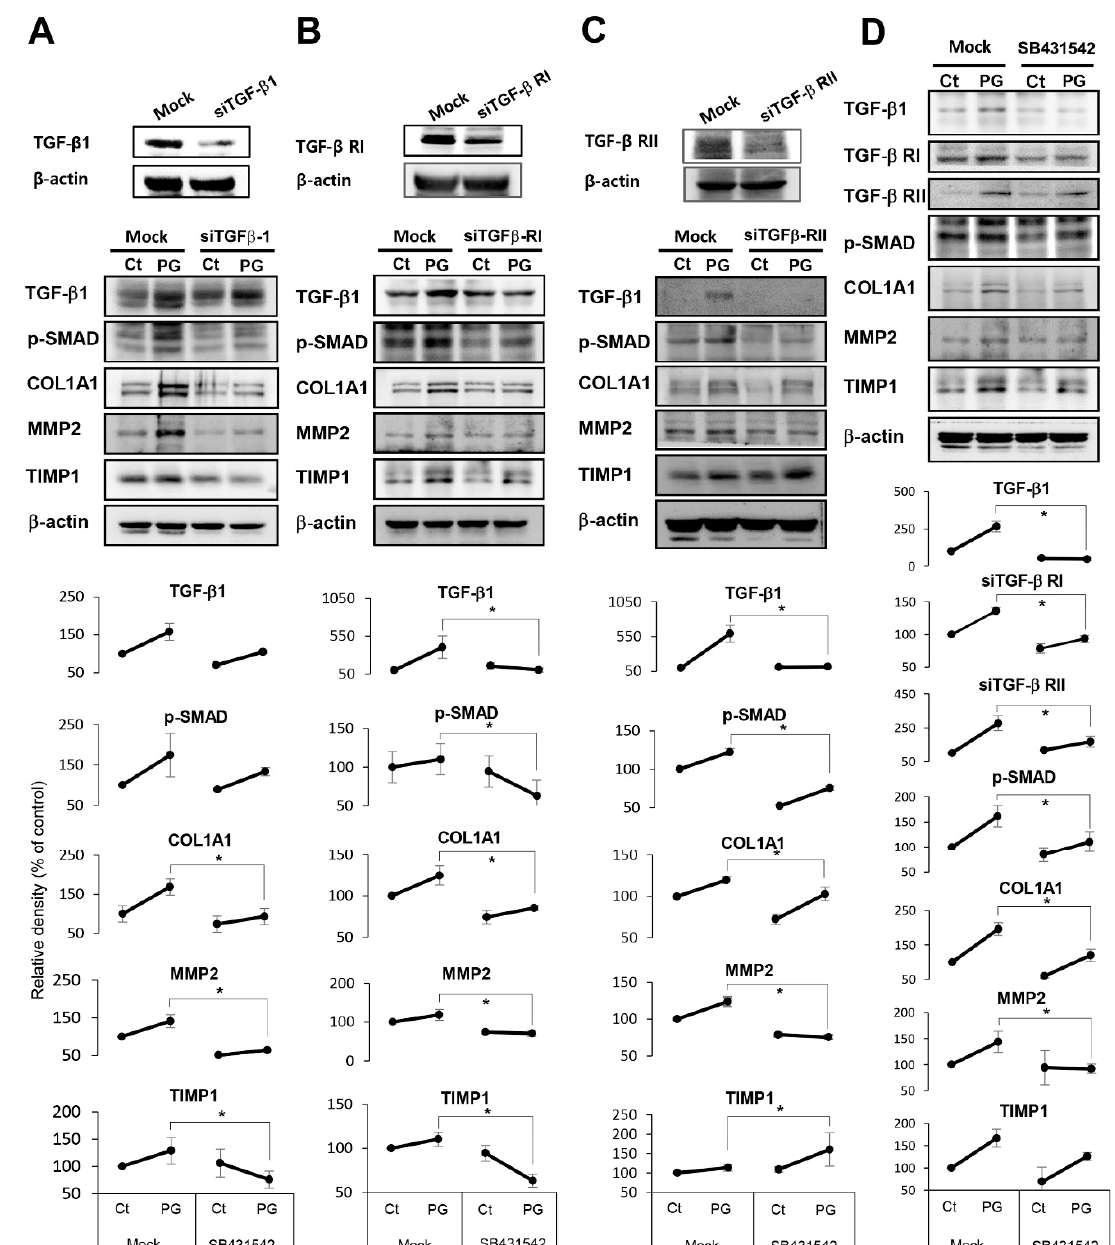
Figure 5. In vitro demonstration of mechanism leading to pancreatic fibrosis by penicillin G. ( A ) Western blot analysis of HPSCs after treating penicillin G followed by addition of TGF- β 1 siRNA. The addition of TGF- β 1 siRNA significantly abrogated profibrotic e ff ects of penicillin G, demonstrated by the lower expression of profibrotic markers, such as collagen, MMP2, and p-SMAD. ( B ) Western blot analysis of HPSCs after treatment with penicillin G followed by addition of TGF- β receptor I (TGF- β RI) siRNA. The addition of TGF- β 1 siRNA significantly abrogated profibrotic e ff ects of penicillin G. ( C ) Western blot analysis of HPSCs after injecting penicillin G followed by addition of TGF- β receptor II (TGF- β RI) siRNA. The addition of TGF- β 1 RI siRNA also significantly abrogated profibrotic e ff ects of penicillin ( D ) Alterations in fibrosis-related factors after treatment of pancreatic tissue with Penicillin G combined with SB431542, an inhibitor of the TGF- β 1 receptor. Treatment with SB431542 significantly abrogated the expression of all fibrosis-related factors that had been increased by Penicillin G. * p < 0.05.